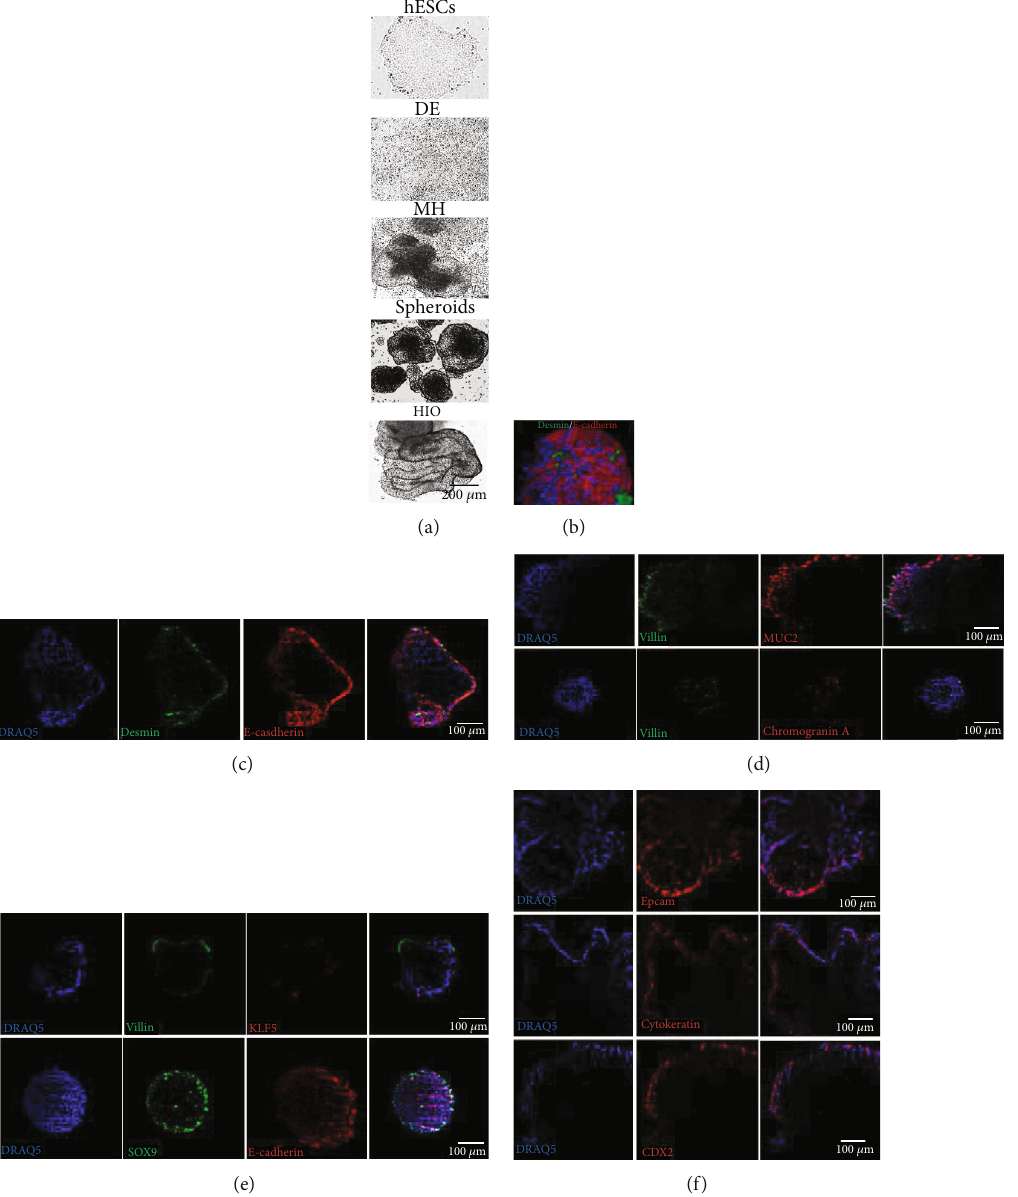
Figure 1: Development and characterization of HIOs. (a) Developmental stages of HIO formation. (b, c) HIOs stained against Desmin and E- cadherin, indicating fi broblast and epithelial cell populations, respectively. (d) HIOs stained positive for EpCam, cytokeratin, and CDX2, indicating intestinal epithelial cells. (e) MUC2-positive goblet cells and Chromogranin A-positive endocrine epithelial cells found in HIOs, surrounded by Villin-expressing epithelial cells. (f) HIOs stained positive for either KLF5 or SOX9, indicating the existence of intestinal epithelial stem cell niches that support the already-di ff erentiated E-cadherin- and Villin-expressing epithelial cells. Representative 40x snapshots are shown in (a) and 28.8x immuno fl uorescence images in (b – f). (b – f) Images were obtained using a light sheet microscope. (c – f) Images are selected z -slices from the HIO total volume. (b) A 3D volume of an